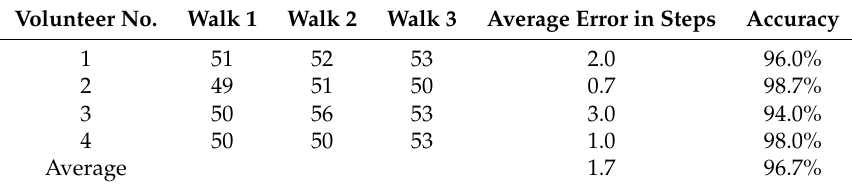
Table 17. Step detection using a Samsung